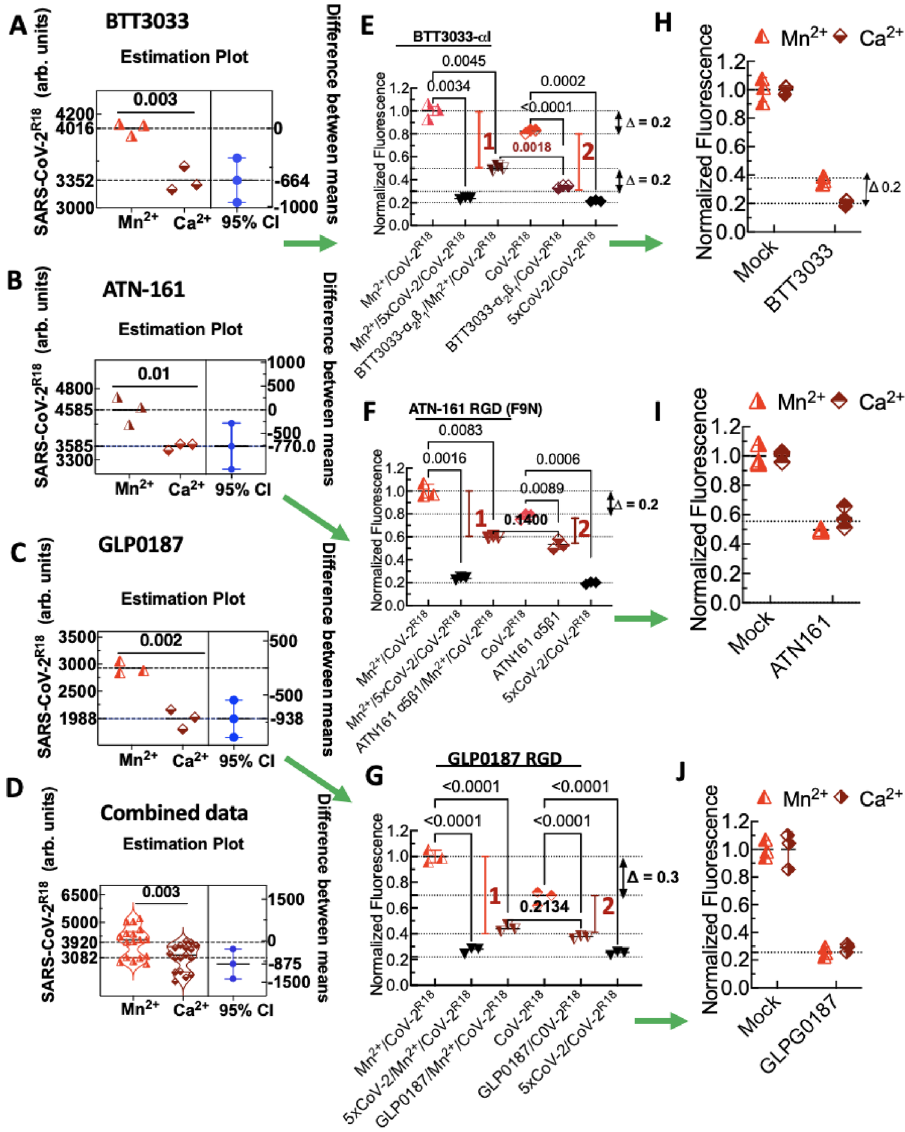
Figure 3. Flow cytometry assays of binding inhibition of SARS-CoV-2 R18 show specificity of αI allosteric antagonist BTT 3033, RGD fibronectin synergy domain (F9N) ATN-161, and broad-spectrum RGD antagonist, GLPG0187. Vero E6 suspension cells in 40 µl volumes (1000 cells/µl) were first incubated with 10 µM integrin antagonists or 5× unlabeled Sars- CoV-2 (CoV-2) in ± Mn 2+ media for 20 min at 37 °C. Sars-CoV-2 R18 was then added to the tubes and incubated for another 20 min. The samples were centrifuged and resuspended in 95 µl HHB buffer and analyzed on a flow cytometer. ( A – D ) Raw data panels of SARS-CoV-2 R18 binding to Mn 2+ activated and resting cells. Each data symbol in the left panels shows triplicate measurements of a single functional test experiment measuring the effect of 1 mM Mn 2+ on equilibrium binding of SARS- CoV-2 R18 to Vero E6 cells. The right panels show differences between the means of Mn 2+ -replete samples and Mn 2+ -free samples, and the left panels show 95% confidence intervals (CI). Green arrows are used to link the analysis results of the same experiment. Combined data show negative controls of multiple experiments (n = 6) testing different inhibitors. As demonstrated for GLP, samples treated with the virus as a limiting reagent yielded lower signals for Mn 2+ and Ca 2+ as shown for GLP). ( E ) Effect of BTT 3033 on SARS-CoV-2 R18 binding to cells. Red vertical bars 1 and 2 denote the difference between mock- and inhibitor-treated samples for Mn 2+ -replete and Mn 2+ -free samples. ( top) ∆ = 0.2, refers to the relative difference in fluorescence intensity due to SARS-CoV-2 R18 in Mn 2+ -replete samples and Mn 2+ free samples; (bottom) ∆ = 0.2 , refers to the fractional difference inhibition of SARS-CoV-2 R18 binding by BTT 3033 in Mn 2+ -replete cells and Mn-free samples, indicating that BTT 3033 is a selective inhibitor of quiescent integrins. ( F ) Effect of ATN-160 on SARS-CoV-2 R18 binding to cells indicating that ATN-160 is agnostic of integrin activation status. ( G ) Effect of GLP0187 on SARS-CoV-2 R18 binding to cells. The gap between Mn 2+ activated cells, and quiescent is shown to be higher ∆ = 0.3 when the virus was used as a limiting reagent < 5000 SARS-CoV-2 R18 /cell as indicated by a lower signal in the raw data ( C , D ). ( H – J ) Specific binding of SARS-CoV- 2 R18 to cells determined by subtraction of non-specific binding represented by 5xCov-2 data points. The data are normalized to mock-treated cells (no inhibitors). Data are representative of at least 3 separate measurements for each inhibitor . The p-values between samples are indicated on the horizontal bar . The figure was produced in GraphPad Prism version